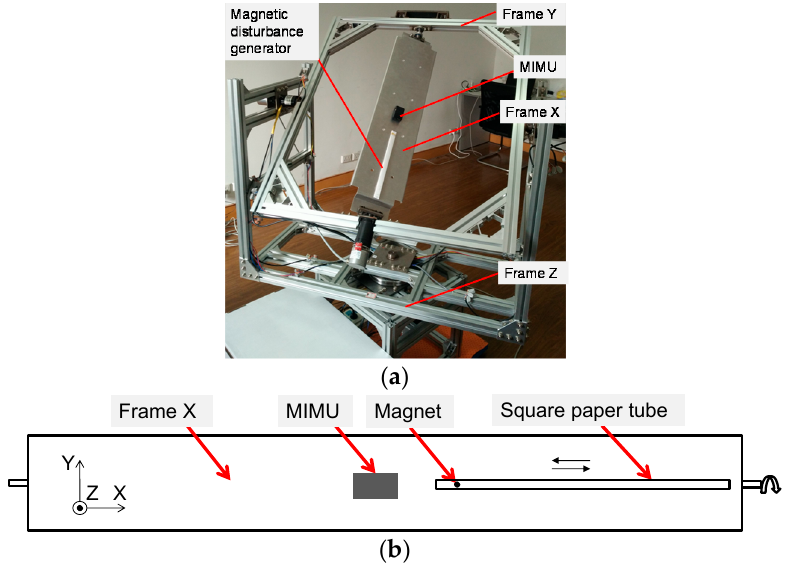
Figure 5. ( a ) MIMU accuracy evaluation setup; ( b ) The detail of the magnetic disturbance generator.